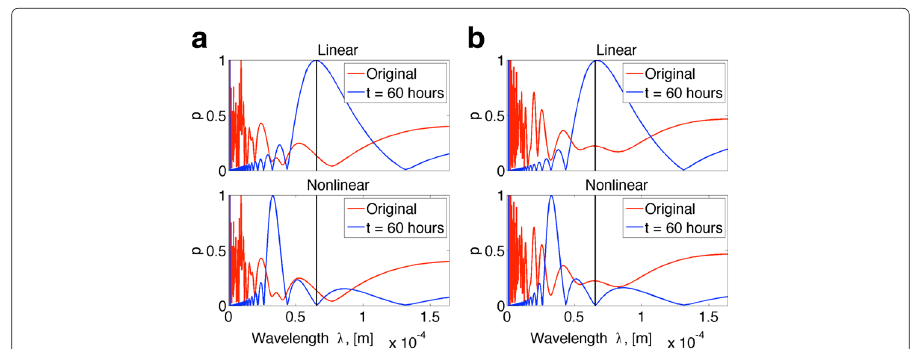
Fig. 9 Distribution function of the wavelengths corresponding to the surface modes present at time t=0 ( red ) and after 60 h of exposure ( blue ), for θ = 0°. Note that in case of linear evolution ( top ), in both the ( a ) x-direction ( b ) y-direction, the dominant wavelength present in the spectrum matches closely with the analytical prediction according to linear stability analysis (shown by verticalblackline ). Nonlinear evolution ( bottom ) shows a final wavelength that is approximately half the analytical description, indicating the coupling of 2 (cid:6) q has taken over the